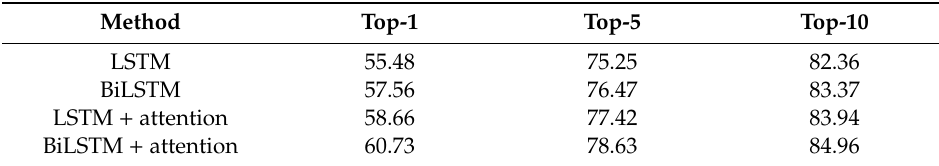
Table 3. Text attention network e ff ectiveness experimental results.